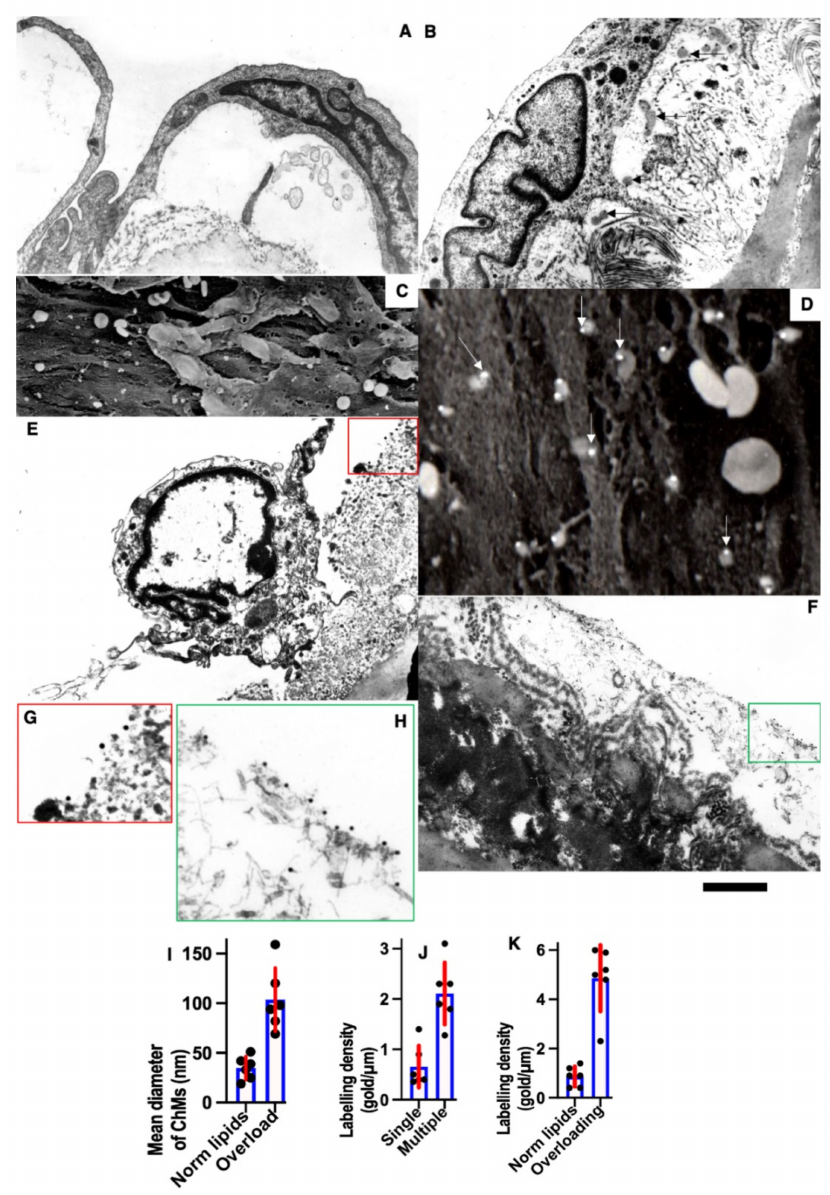
Figure 11. Role of extensive synthesis of the BM by ECs and overloading of enterocytes alter binding of LDLs to the BM. ( A ) Incubation with LDL obtained from the control rats fed with small amount of lipids. TEM. ( B ) Incubation of aorta with LDLs obtained from rats fed with high amount of lipids. Arrows show LDLs bound to the BM. TEM. ( C ) SEM of the nude BM incubated with LDLs obtained from normal rats. ( D ) SEM of the nude ECBM incubated with normal LDLs after multiple cryoinjuries. Higher number of LDLs labeled with gold (white arrows) are more visible than in ( C ). Quantified in ( I ). ( E ) Incubation of the nude aortic BM with the Limax flavus lectin. Attachment of gold labeled lectin to the BM is shown in ( G ) under higher magnification. ( F ) After multiple cryoinjuries, the level of the lectin attachment was higher. ( G , H ) Enlarged areas indicated in ( E ) and ( F ) correspondingly. Quantified in ( J ). ( I ) Overloading of enterocytes with lipids induces significant ( p < 0.05) augmentation of the diameter of chylomicrons. ( J ) After multiple cryoinjuries, the nude BM of aortic ECs captured significantly ( p < 0.05) more LDLs than after a single cryoinjury and consecutive re-endothelialization. ( K ) LDLs obtained from rats after their overloading with lipids (Overloading) had significantly ( p < 0.05) higher affinity to the BM of the nude BM of the aortic BM than LDLs isolated from rats fed with lower amount of lipids (Norm lipids). Scale bars: 3.5 µ m ( A ); 2.5 µ m ( B ) 25 µ m ( C , D ); 3.2 µ m ( E ); 3.6 µ m ( F